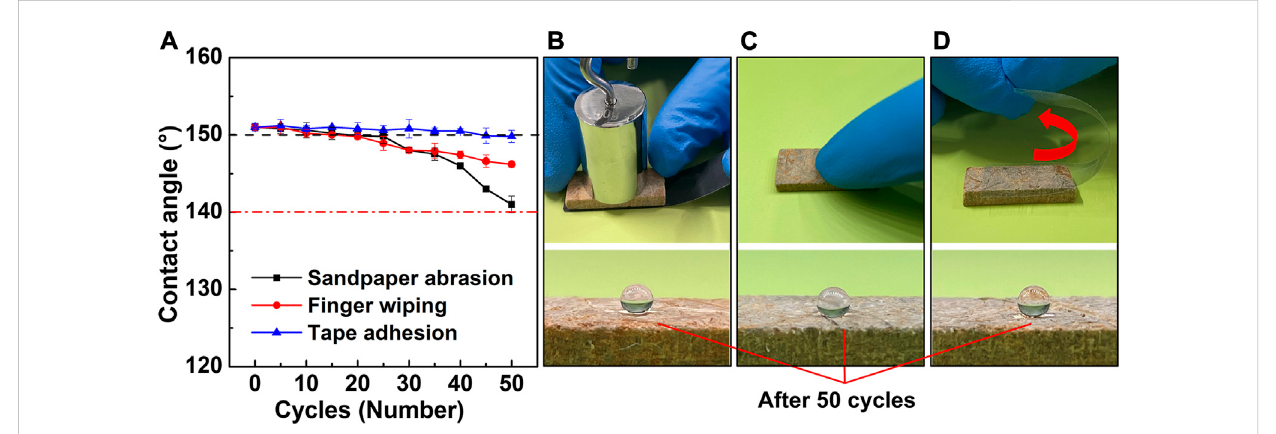
FIGURE 8 Contact angle variation of (A) BPC-TiO 2 -F surfaces during (B) sandpaper abrasion, (C) fi nger wiping, and (D) tape